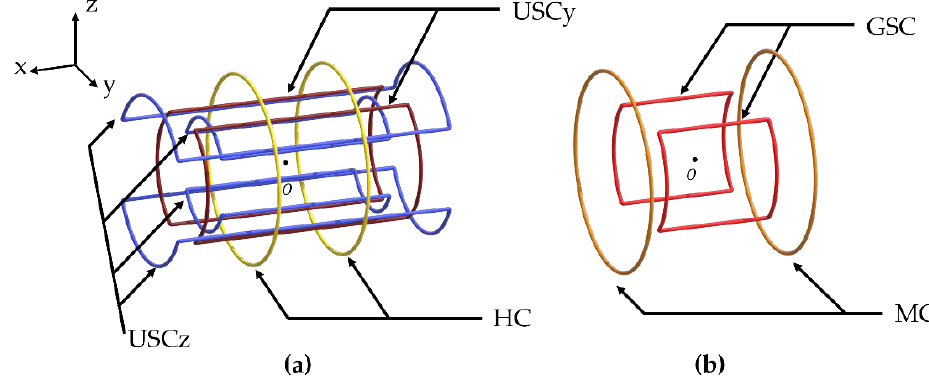
Figure 1. The proposed novel arrangement of five pairs of coils to enable the MNS to generate the maximum 3D rotating magnetic field: ( a ) three pairs of coils (HC, USCy, and USCz) generate the uniform magnetic field; ( b ) two pairs of coils (MC and GSC) generate the uniform magnetic field gradient.